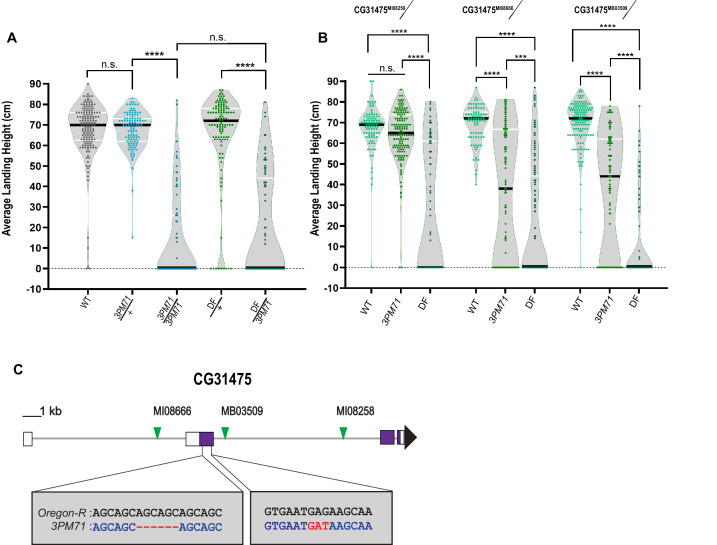
3PM71 mutation maps to CG31475.(A) Deficiency mapping of 3PM71 mutants to a small region of chromosome 3R using Df(3R)ED5938. The average landing height (cm) and sample size for each group as ordered in the figure are, WT 67.4 cm, n = 149, 3PM71/+ 67.4 cm, n = 108, 3PM71 13.3 cm, n = 77, Df(3R)ED5938/+ 65.4 cm, n = 113, and Df(3R)ED5938/3PM71 20.2 cm, n = 73. (B) Flight performance of insertion alleles in CG31475 (CG31475MI08258, CG31475MI08666, and CG31475MB03509) alone and in combination with 3PM71 and Df(3R)ED5938. For each group, the landing average (cm) and sample size are as follows: CG31475MI08258/+ 67.5 cm, n = 92, CG31475MI08258/3PM71 64.3 cm, n = 140, CG31475MI08258/Df 26.9 cm, n = 78, CG31475MI08666/+ 69.3 cm, n = 81, CG31475MI08666/3PM71 36.2 cm, n = 108, CG31475MI08666/Df 20.4 cm, n = 156, CG31475MB03509/+ 69.3 cm, n = 137, CG31475MB03509/3PM71 36.9 cm, n = 101, and CG31475MB03509/Df 11.6 cm, n = 72. (C) 3PM71 mutants map to the previously uncharacterized gene, CG31475. Green arrows represent the location of current CG31475 alleles. White and purple boxes represent exons. Black bars represent the median values. and ****p<0.0001, ***p<0.001, using A Brown-Forsythe and Welch ANOVA tests with Post hoc Games-Howell’s multiple comparisons. N.S. = Not Significant.
Figure 3—source data 1.Raw data for Figure 3 flight scores.

Figure 3—source data 2.Raw data for transcript expression.